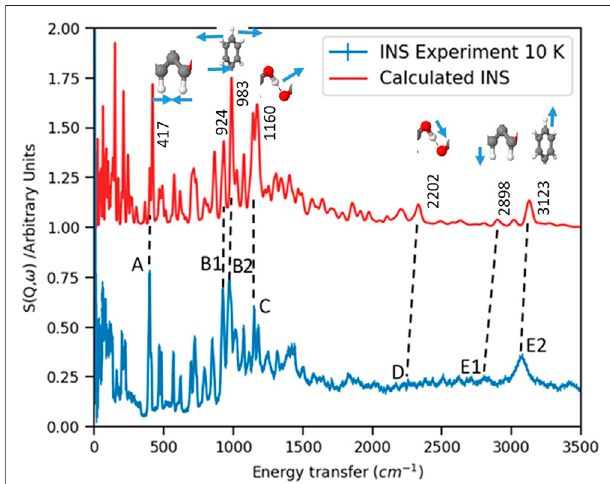
FIGURE2| INS spectrum iscomparedwith DFT calculations.Important peaks are labeled by frequencies of normal modes along with structures of functional groups responsible for those modes. The direction of vibrations of respective atoms are indicated by small arrows. See text for more